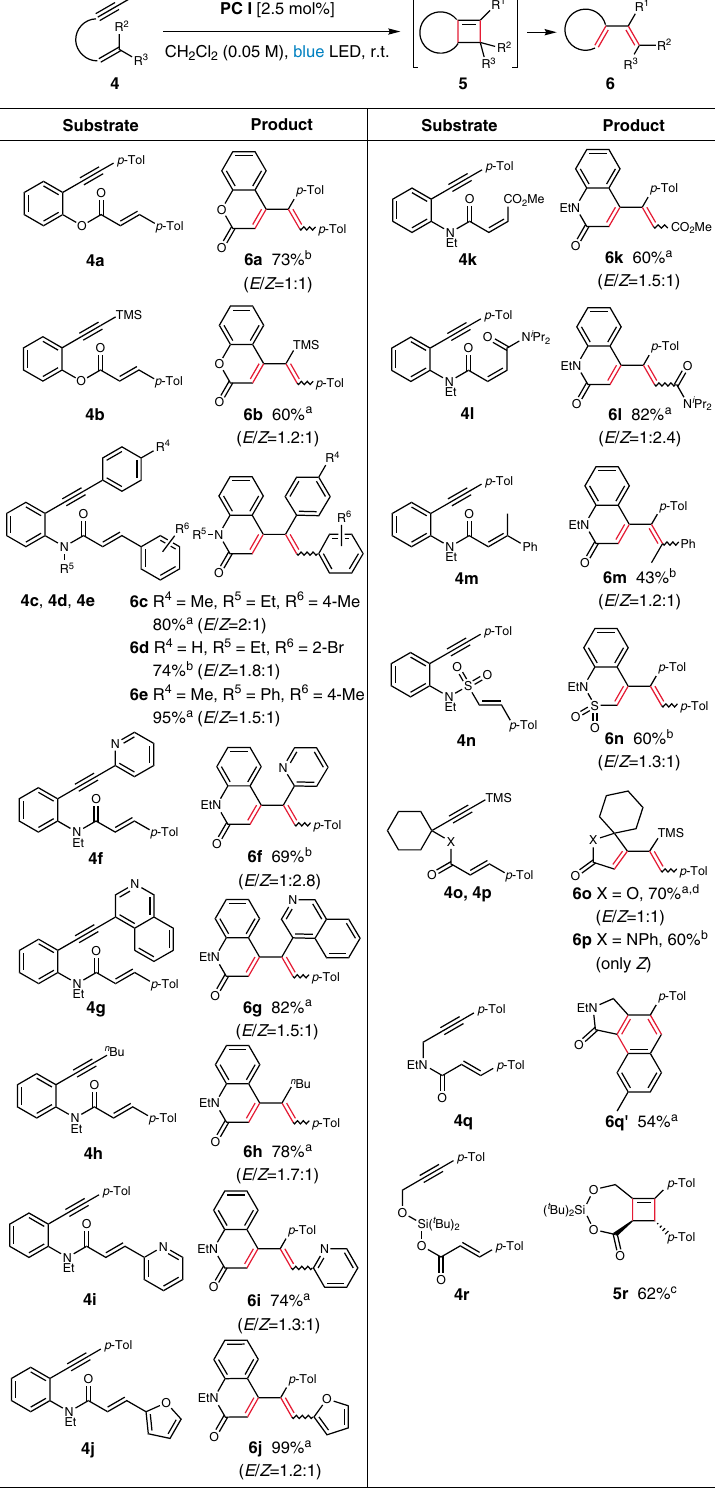
Fig. 3 Scope of the intramolecular reaction. Unless noted otherwise, all reactions were conducted in 0.1 mmol scale under irradiation of 12 W blue LED strip and Ar atmosphere; Isolated yields. a Reaction time: 1 – 18 h. b Reaction time: 24 – 48 h. c Reaction time: 60 h, racemate for 5r . d Reaction was conducted with 0.05 mmol scale; Reaction concentration: 0.01